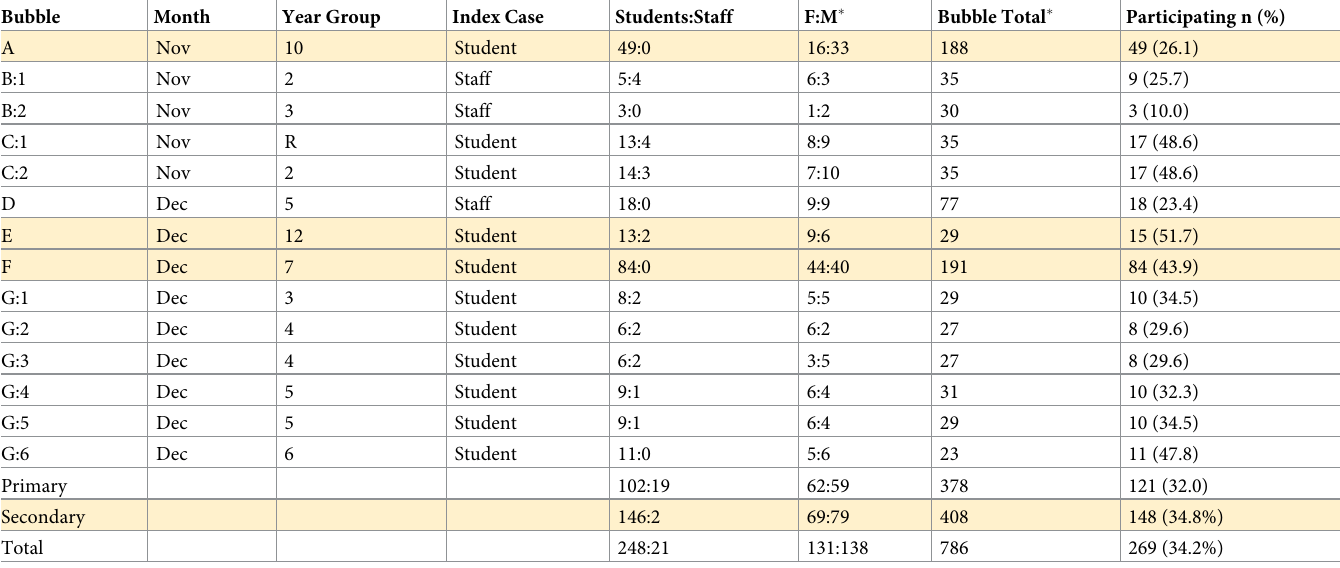
Table 1. Demographics of participating direct contacts by